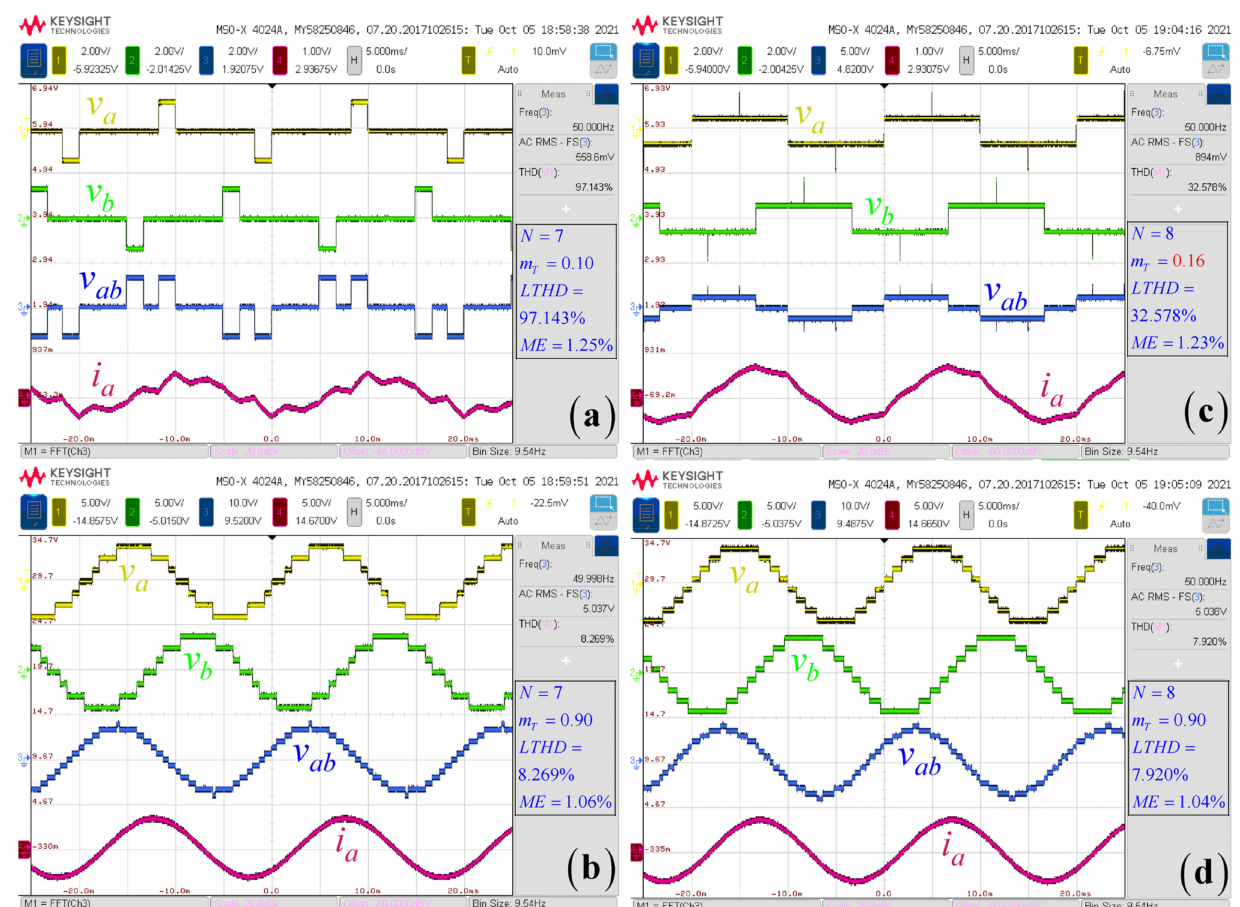
Figure 12. Real-Time experimental (C-HIL) results of optimal LTHD-based SCM (phase voltage, line voltage, and load current waveforms): ( a ) 7 Level CHB at m T = 0.1, ( b ) 7 Level CHB at m T = 0.9, ( c) 8 Level DDC at m T = 0.16, ( d ) 8 Level DDC at m T =